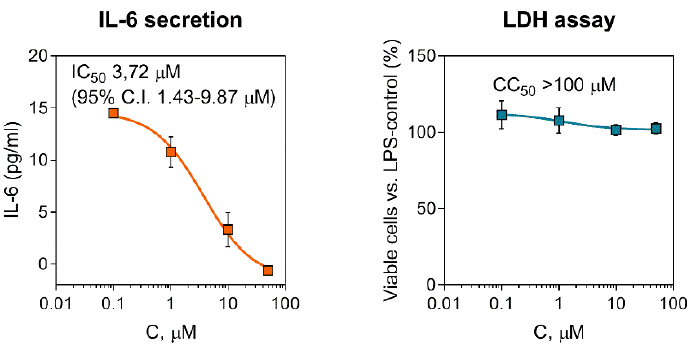
Figure 3. Effect of compound 9g on IL-6 secretion and the viability of LPS-stimulated peritoneal macrophages of C57bl/6j mice. Data are shown as mean ± SD ( n = 3). After 24-h of incubation, dexamethasone, but not compound 9g , significantly sup- pressed phagocytosis (data not shown). As shown in Figure 4, after 72 h of incubation, the proportion of phagocytes in the dexamethasone-treated cells further decreased from 57% to 41%, which coincides with the literature’s data [28,29]. The mean number of phagocytosed yeast cells was decreased by 59%. Compound 9g preserved macrophage phagocytic activity and reduced the mean number of phagocytosed particles by 16%. No cytotoxic properties were noted for the tested compound during the experiment. In addition, macrophage spreading was visually scored. Spreading is a well-known phenotypic marker of cell activation, and phagocytic capacity is limited by the amount of available membrane [30,31]. Yeast non-significantly stimulated macrophage spreading, while 9g treatment reduced it to a nearly unstimulated level. The effect of dexamethasone was even more significant. We may conclude that dexamethasone showed a pronounced immunosuppressive effect, while compound 9g preserved the innate phagocytic activity of macrophages.